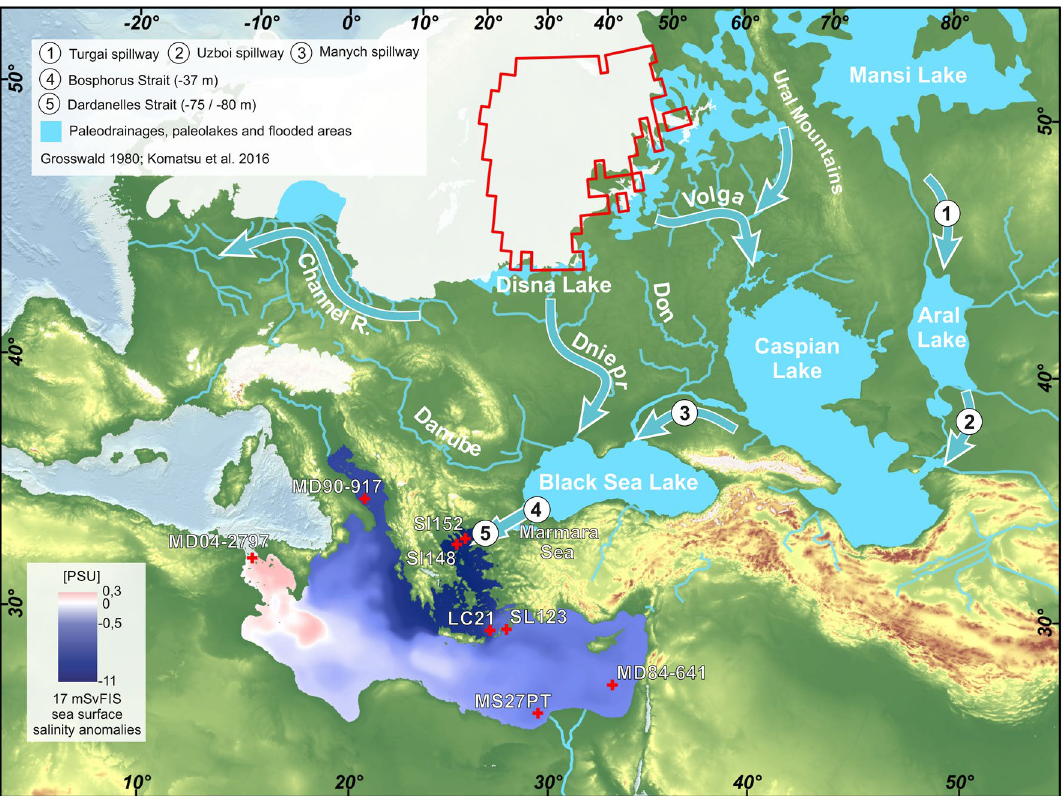
Figure 1. Map of LGM ice caps including the Fennoscandia Ice Sheet 67 and its southward drainage basin with major rivers indicated, including the Volga, Don, and Dnieper 68,69 . The red contour shows the surface area (1,119,166 km 2 ) from which meltwater potentially flows into the Black Sea and Caspian Sea. The